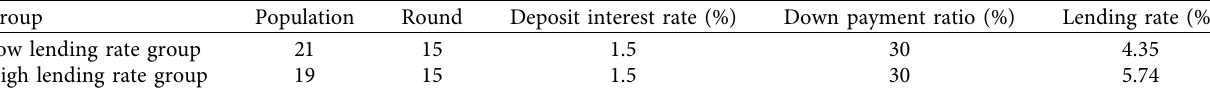
Table 2: Experimental parameter settings of the lending rate